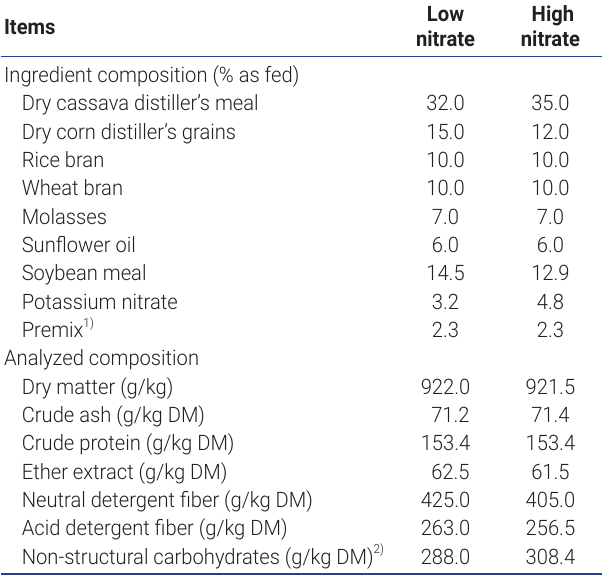
Table 1. The ingredient and chemical composition of the experimen- tal concentrates